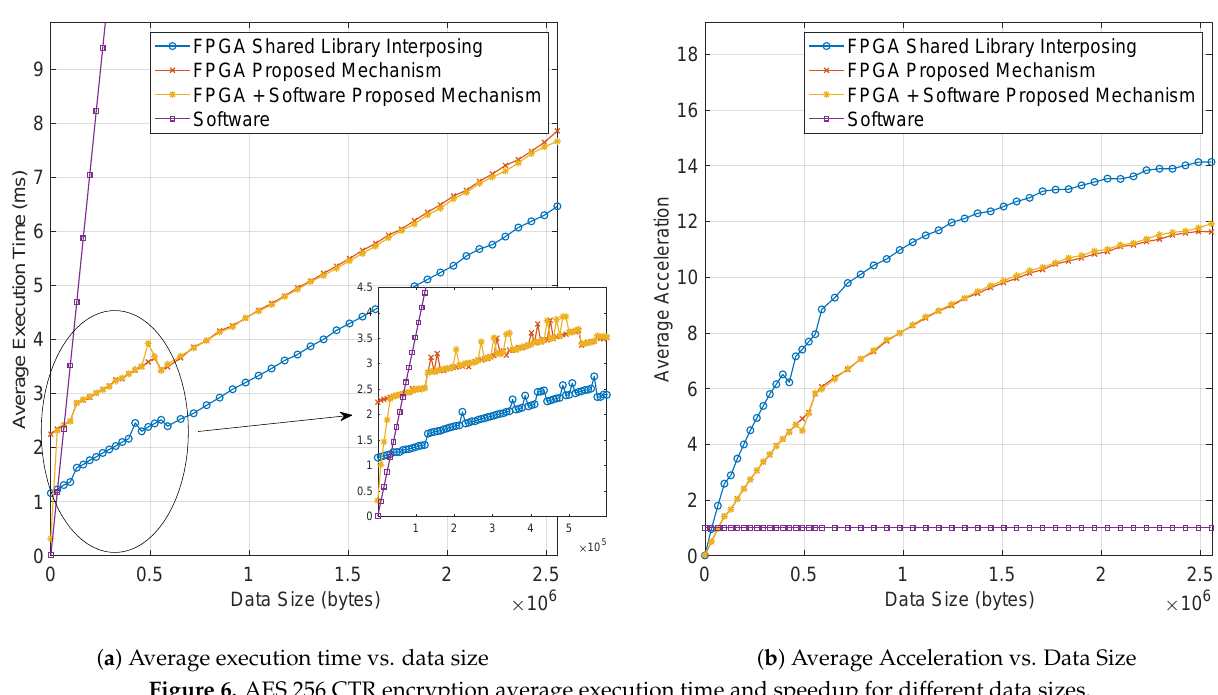
Figure 6. AES 256 CTR encryption average execution time and speedup for different data